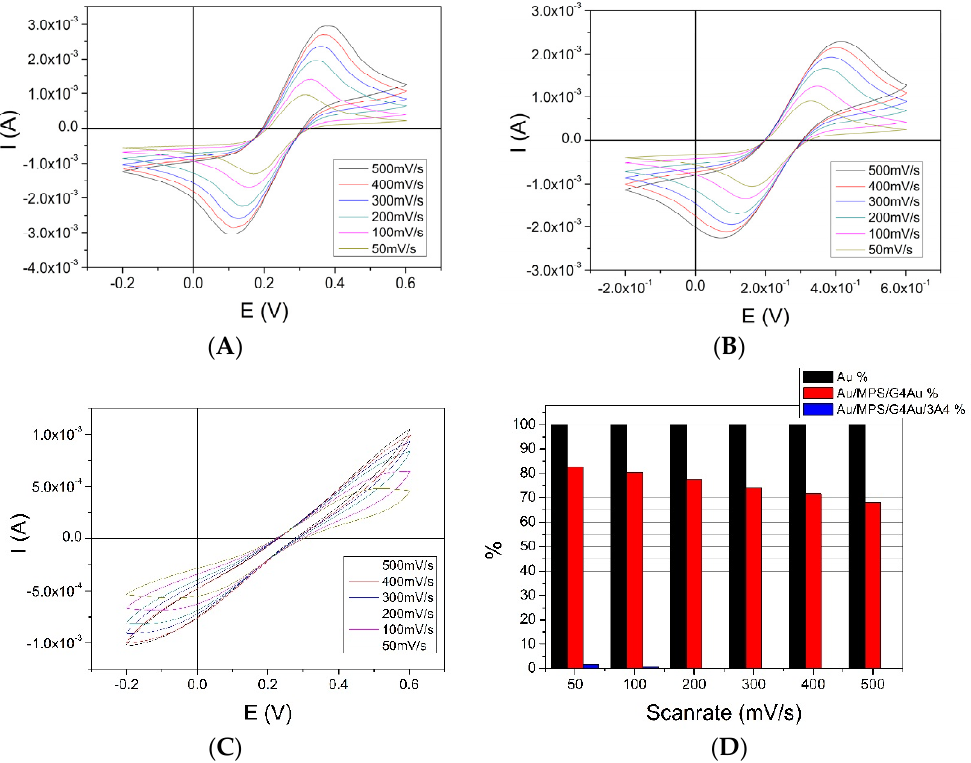
Figure 5. Cyclic voltammograms of 10mM Potassium Ferricyanide using different assembly stages